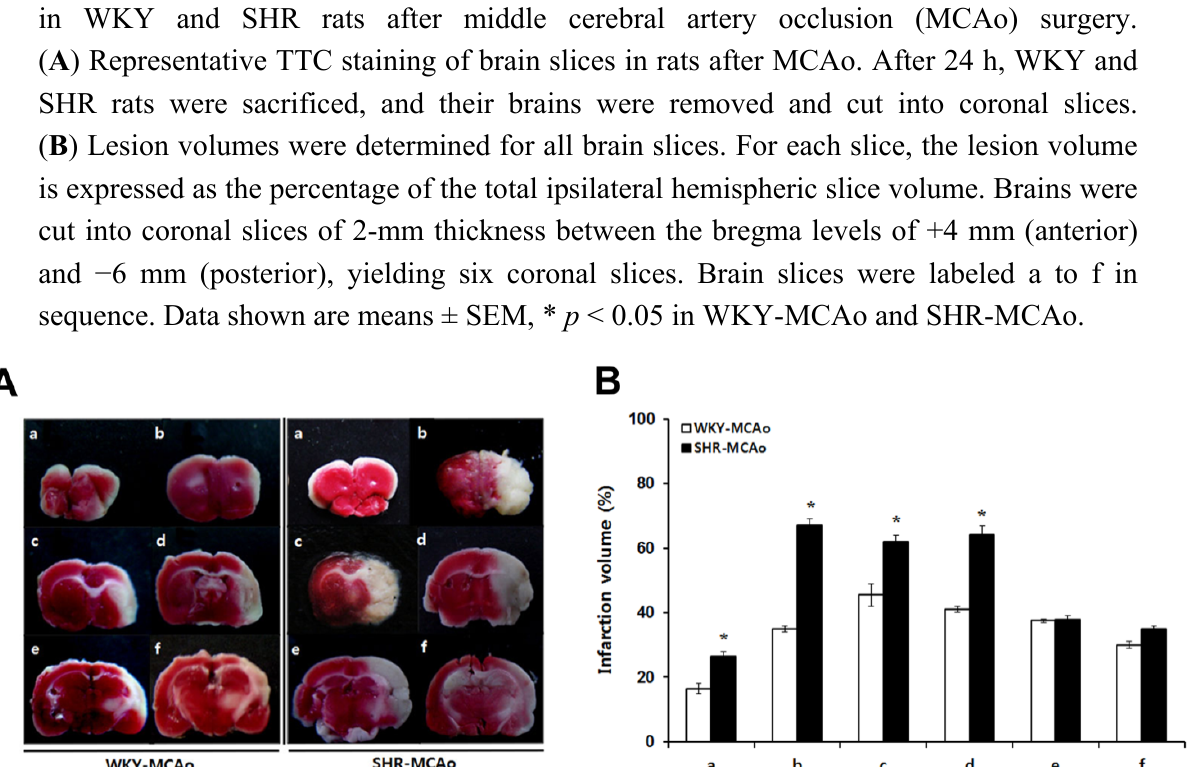
Figure 2. 2,3,5-triphenyltetrazolium chloride (TTC)-defined volume of ischemic lesions in WKY and SHR rats after middle cerebral artery occlusion (MCAo)